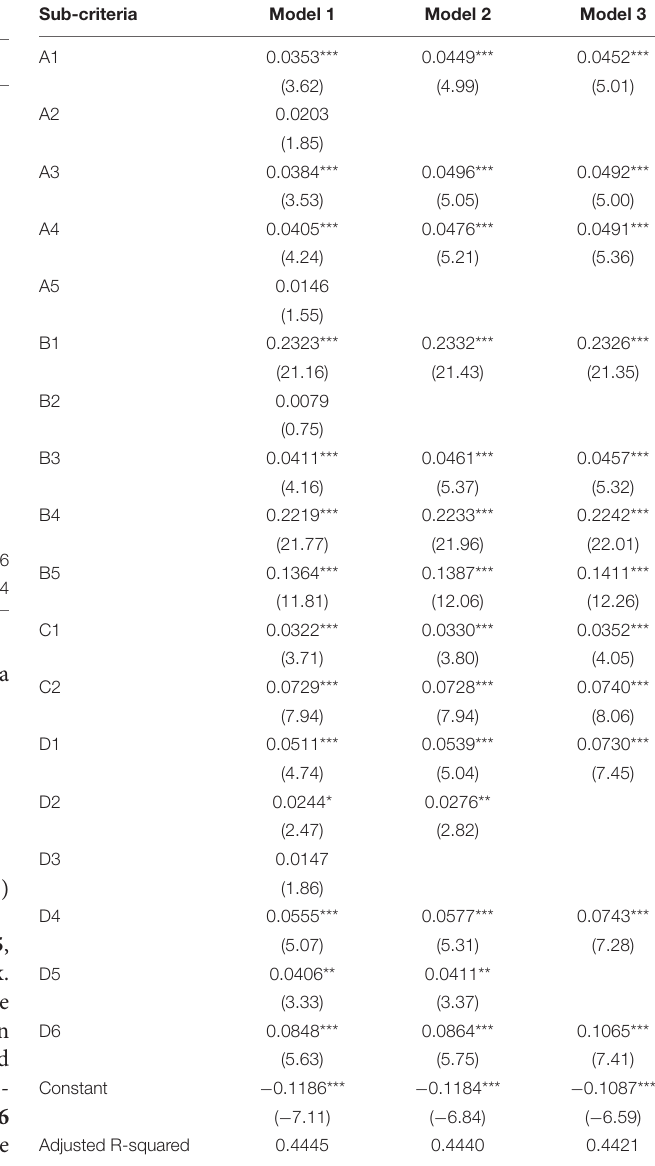
TABLE 3 | The rotated component matrix of each sub-criteria. Sub-criteria